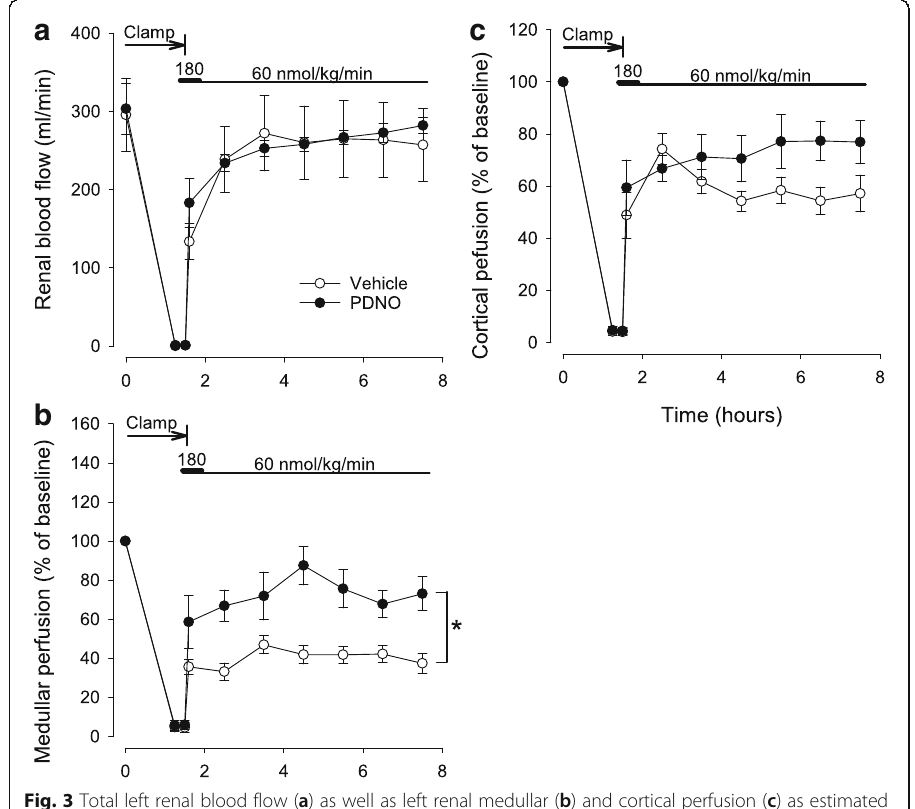
Fig. 3 Total left renal blood flow ( a ) as well as left renal medullar ( b ) and cortical perfusion ( c ) as estimated by laser Doppler in 16 anesthetized sheep subjected to left renal ischemia and reperfusion. Renal ischemia was caused by clamping of the left renal artery for 90 min. Fifteen minutes prior to the release of the clamp intravenous infusions of either the organic mononitrites of 1,2-propanediol (PDNO, n =8) or vehicle (1,2-propanediol + inorganic nitrite, n =8) were commenced. The infusions continued for 6 h. Data are expressed as mean and SEM. Significant ( p <0.05) differences in response to PDNO compared to vehicle is indicated by an